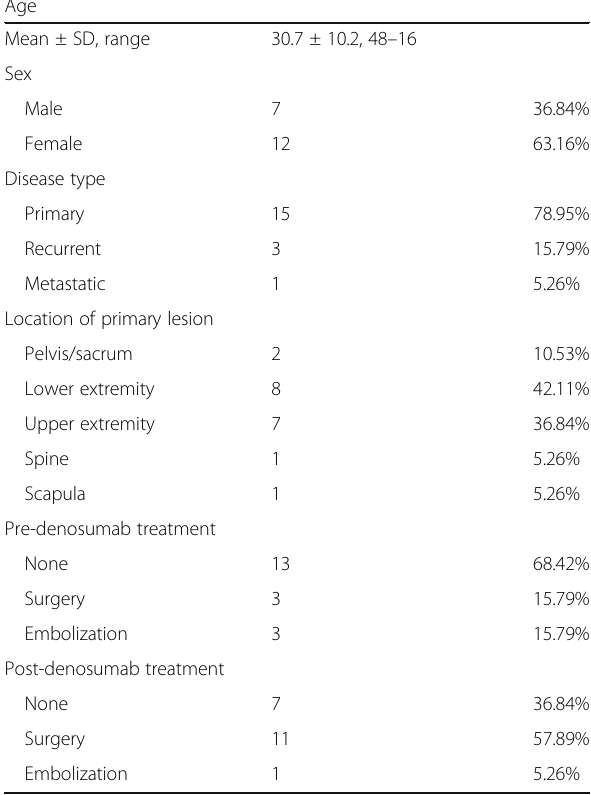
Table 2 Demographic and clinical data of enrolled patients